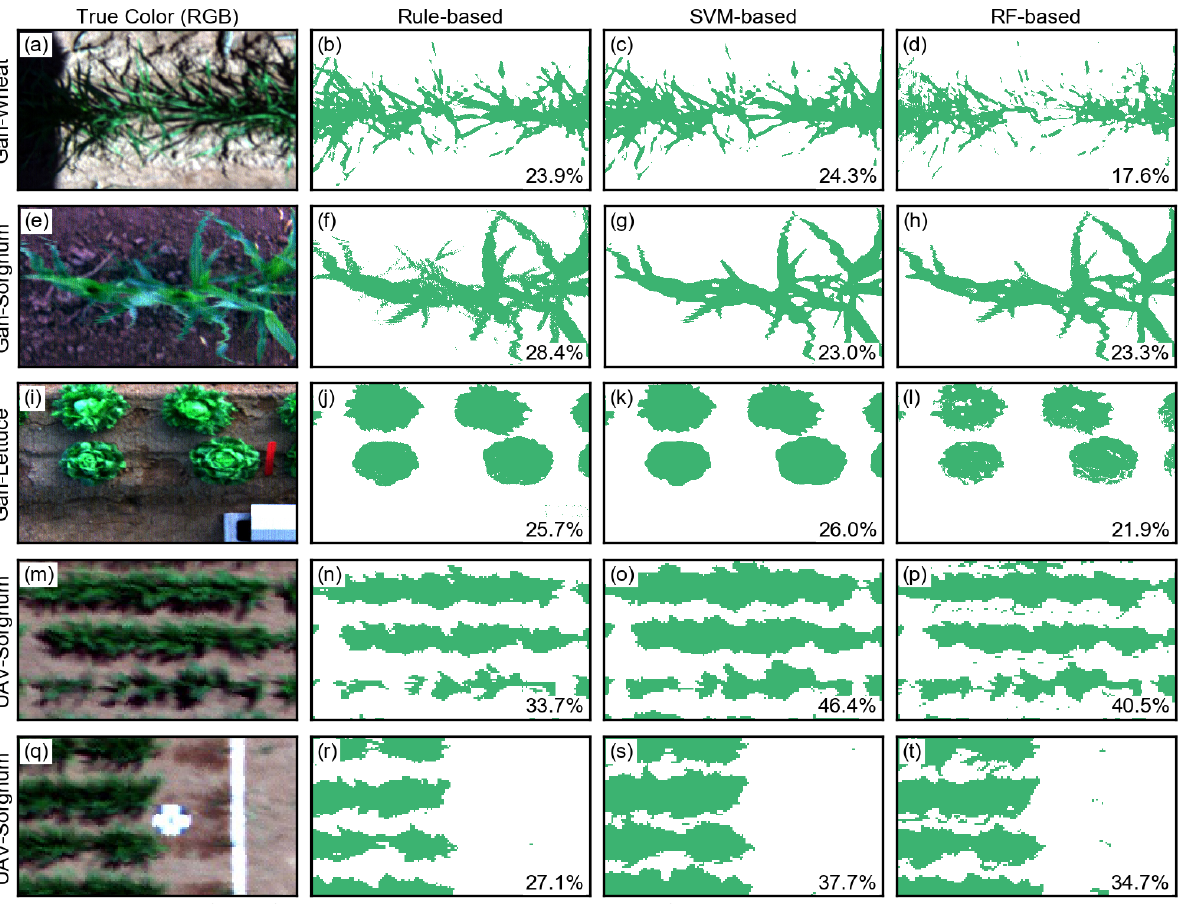
Figure 3. Visualization of classification results and estimated canopy cover for hyperspectral image scenes; Gan-wheat, Gan-sorghum and Gan Lettuce represent gantry-based hyperspectral images collected from wheat, sorghum and lettuce fields.